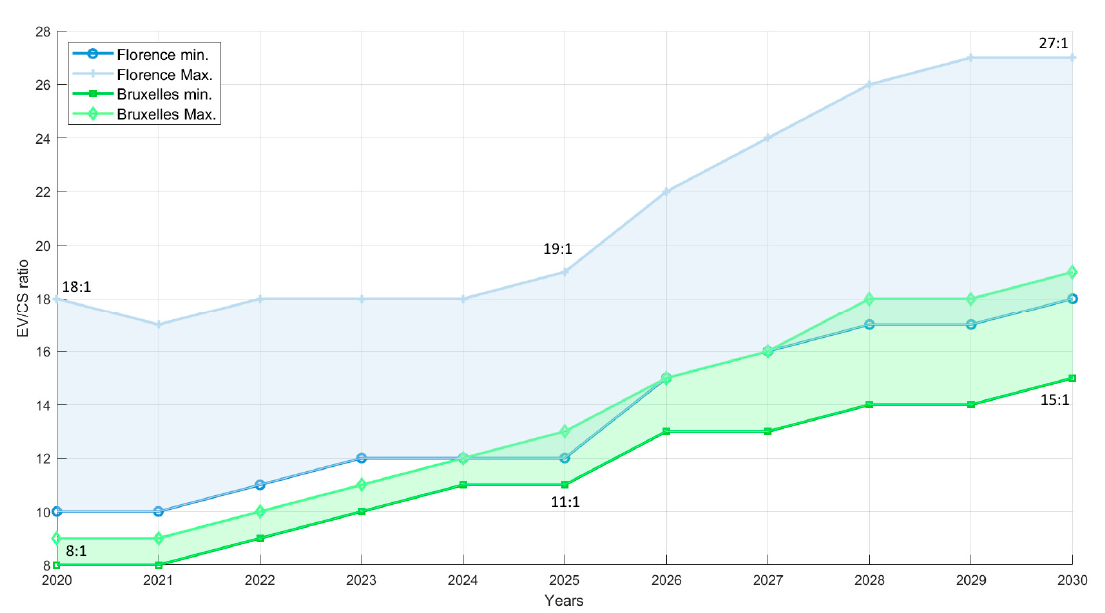
Figure 11. Publicly accessible charging infrastructure electric vehicle (EV) / CS ratio for Florence (light blue) and Bruxelles (light green).